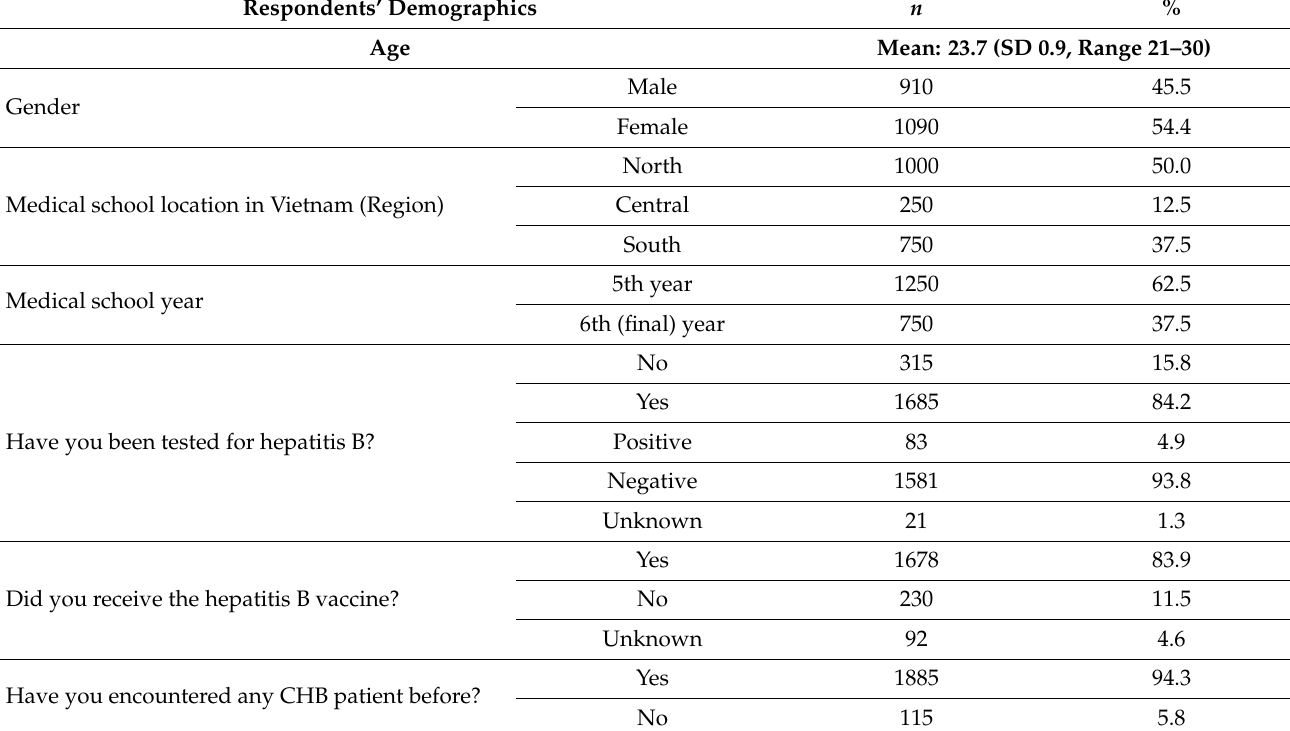
Table 1. Demographics of survey participants ( n =